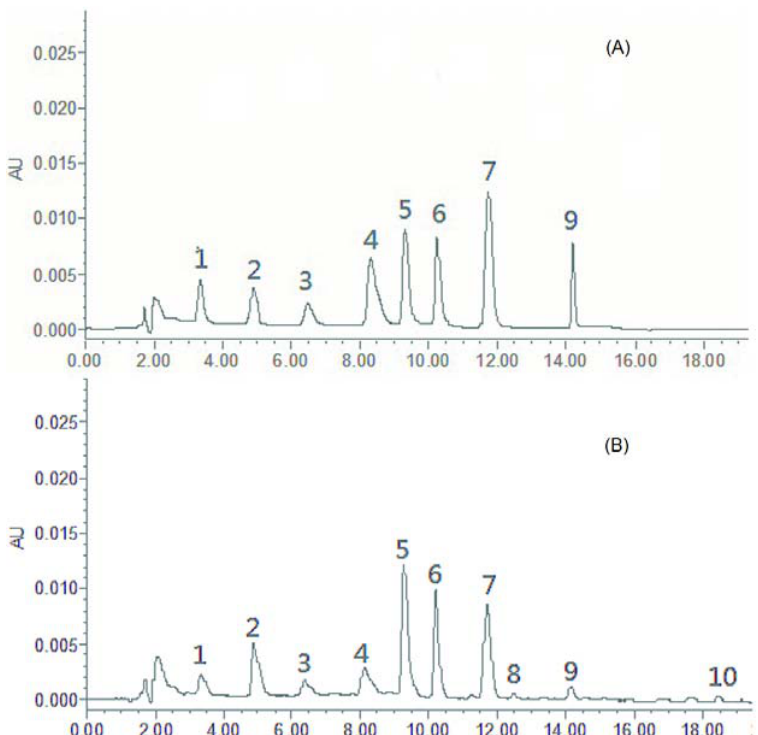
Figure 1. Typical chromatograms for determining the eight bioactive compounds in different samples. ( A ) Mixed standards; ( B ) Radix Isatidis (No. 20101121); ( C ) Banlangen Granules (BLGG) (No. 090921); ( D ) Nan-Banlangen (NBLG) (No. 060308-1).